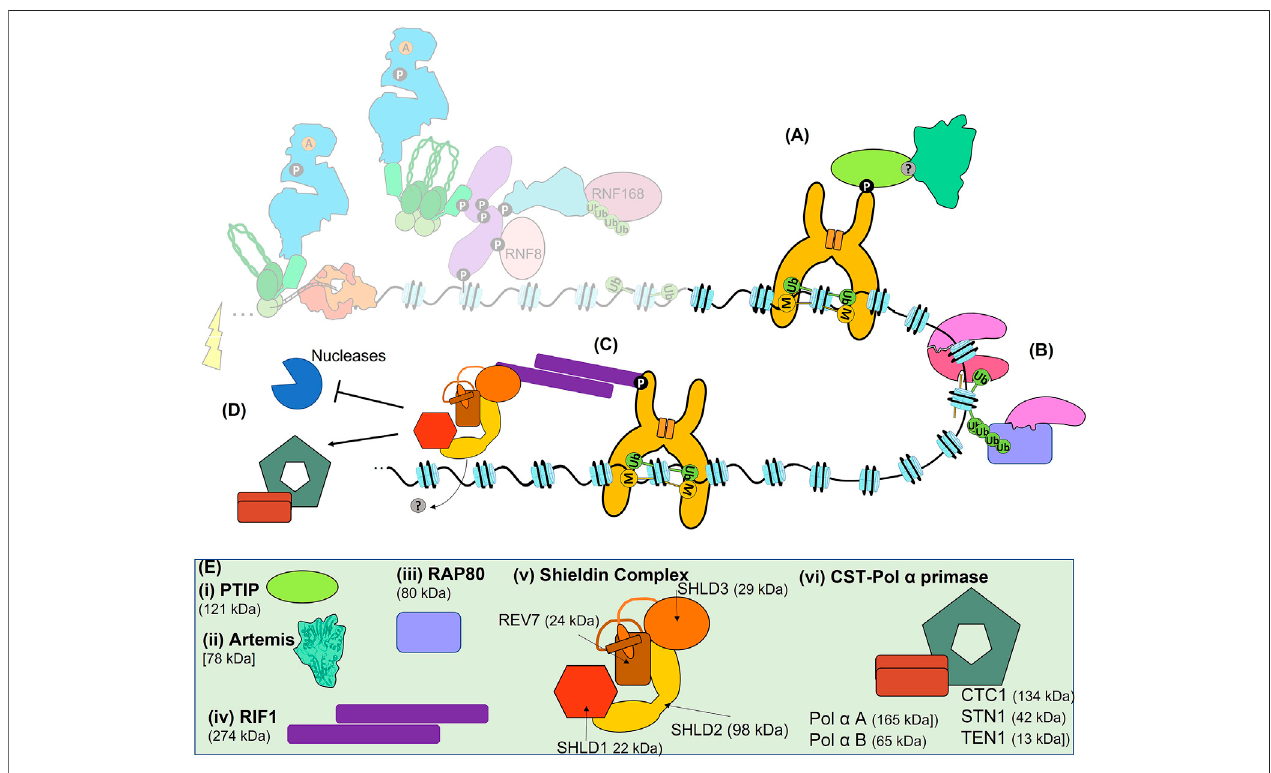
FIGURE 6 | The Late response and pathway choice. (A) 53BP1-dependent recruitment of PTIP recruits Artemis to sites of DSBs for slow-kinetic cNHEJ. (B) Recruitment of BRCA1 to sites of DSBs can be BARD1-dependent, RAP80-dependent, MRN-dependent (not shown) or PARP1-dependent (not shown). (C) Recruitment of RIF1 and Shieldin to 53BP1. (D) 53BP1, RIF1, and Shieldin can block resection, or recruit the CST-Pol α primase complex for gap fi ll-in, promoting the fi delity of both slow-kinetic cNHEJ and HR. (E) Schematics or structures of PTIP, Artemis, RAP80, RIF1, Sheildin and CST- CST-Pol α primase. Where known structure is superimposed within overall architecture as illustrated. (i) PTIP is recruited to phosphorylated 53BP1. (ii) Artemis is the nuclease responsible for the 1 – 5 nt resection required for slow-kinetic cNHEJ. (iii) RAP80 can bind topolyubiquitination ofH2A(X)K13 and H2A(X)K15 torecruitBRCA1. (iv) RIF1 forms adimer via its large N-terminal domain, which can also bind directly to DNA (not shown), and interacts with 53BP1 via phosphorylation. (v) The Shieldin complex is made up of SHLD1, SHLD2, SHLD3, and REV7. REV7 and SHLD3 undergoconformationalchangesthatfacilitate theirinteraction,the so-called ‘ seatbelt ’ interaction. (vi) The CST complex formsadecamericsupercomplexcontainingCTC1,STN1,andTEN1(Limetal.,2020)andinteractswithPol α -primase.Pol α -primaseitselfiscomposedoftwosubunits A and